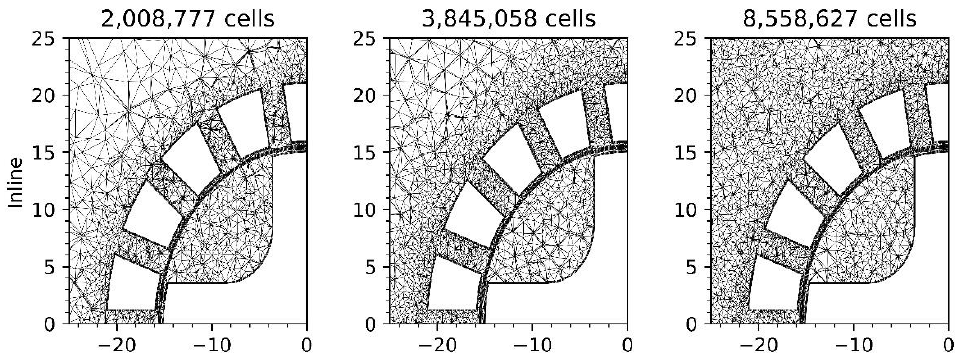
Figure 2. Zoom on the rotor–stator mixer meshes that were used for the grid independence analysis. The slice corresponds to z = 13 mm (confer Figure 1 for the frame of reference).